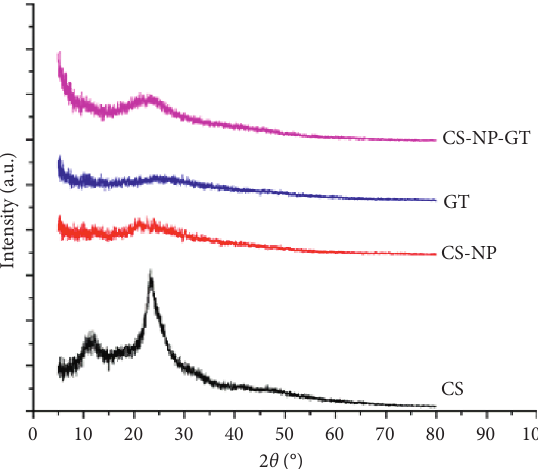
Figure 5: XRD of single ingredients and their complex samples of CS-NP-GT (CS:GT � 1 :0.5), GT, CS-NP, and CS.